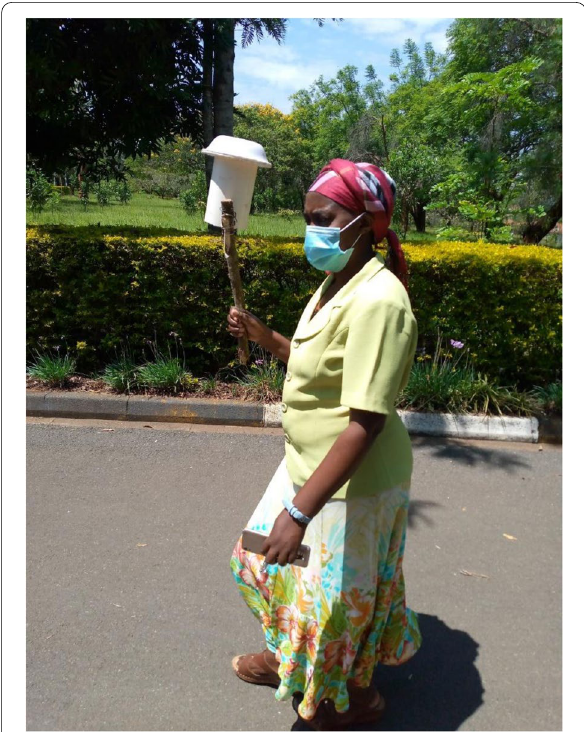
Fig. 4 A fabricated (‘rocket type’) radiation shield containing the Hobo Pendant temperature logger that was used in traverse walk around campus. The radiation shield was developed from 160 mm PVC pipe and white melamine bowls